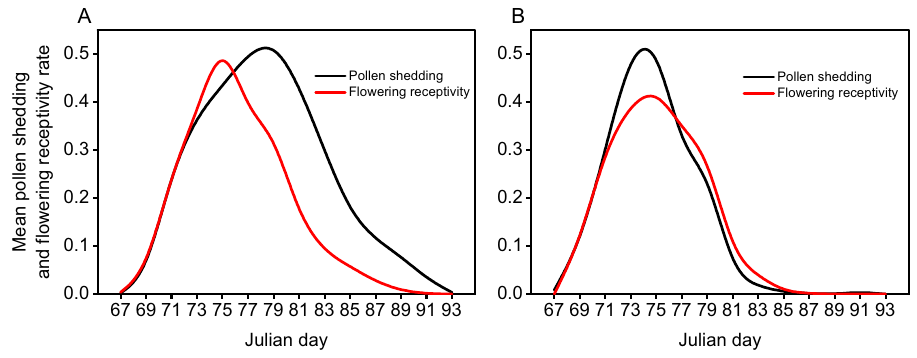
Figure 2. Overall phenology showing the mean pollen shedding rate and female receptivity rate among all clones across the reproductive period for CSO2.5 ( A ) and CSO2 ( B ).